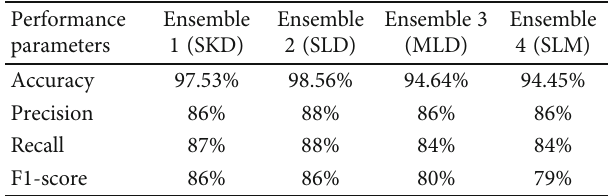
Table 2: Performance of ensemble classi fi ers on dataset 2.